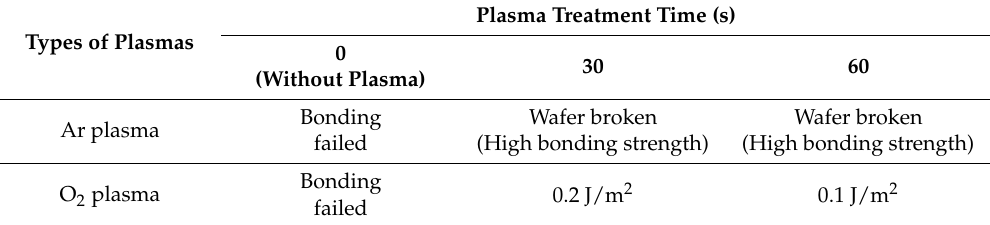
Table 1. Results of room-temperature wafer-scale Au–Au bonding with Ar or O 2 plasma